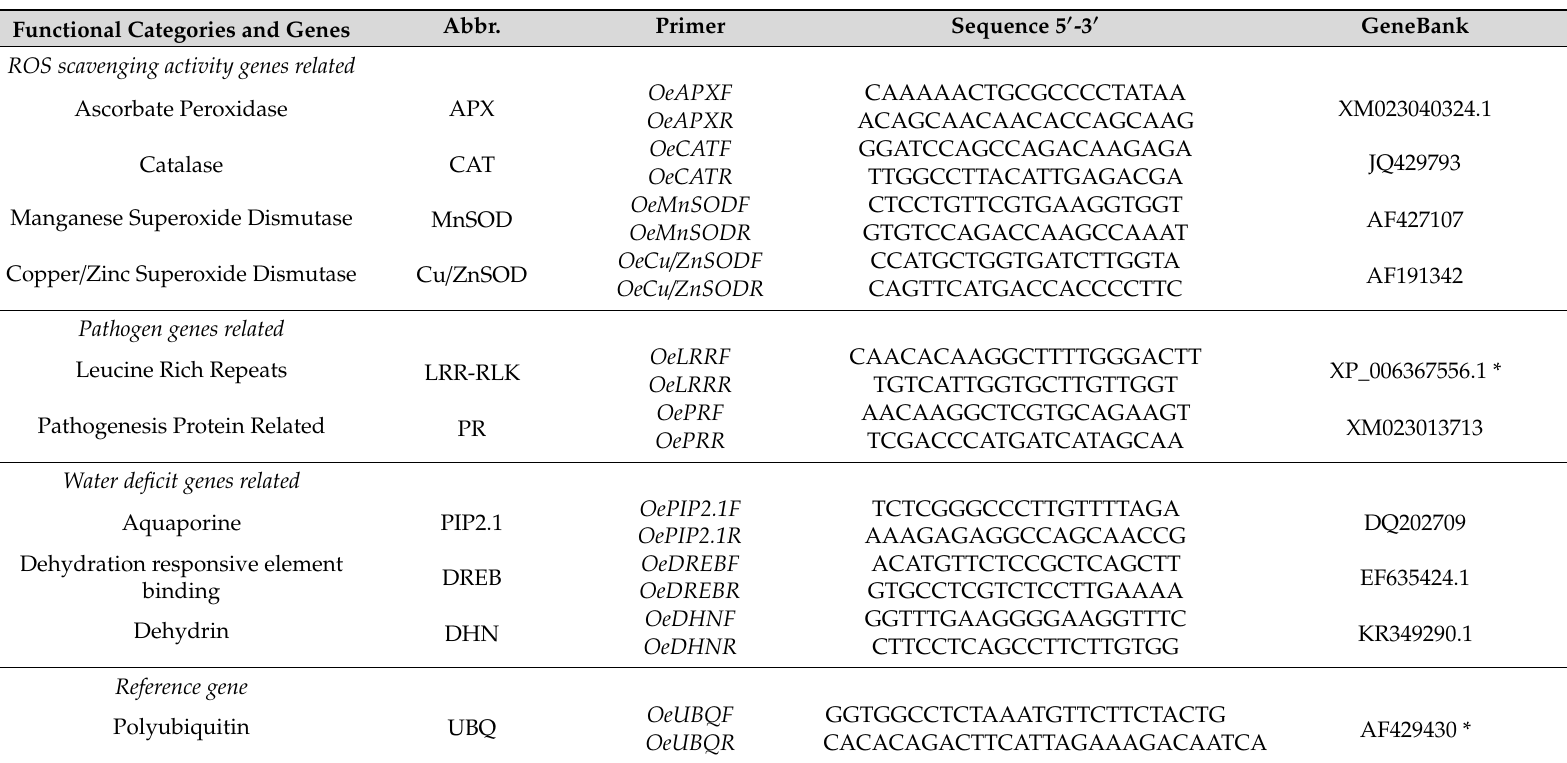
Table 2. Primers used to evaluate the expression of genes involved in drought stress, stress induced by Xylella fastidiosa and combined stresses in Olea europaea L. Cellina di Nard ò and